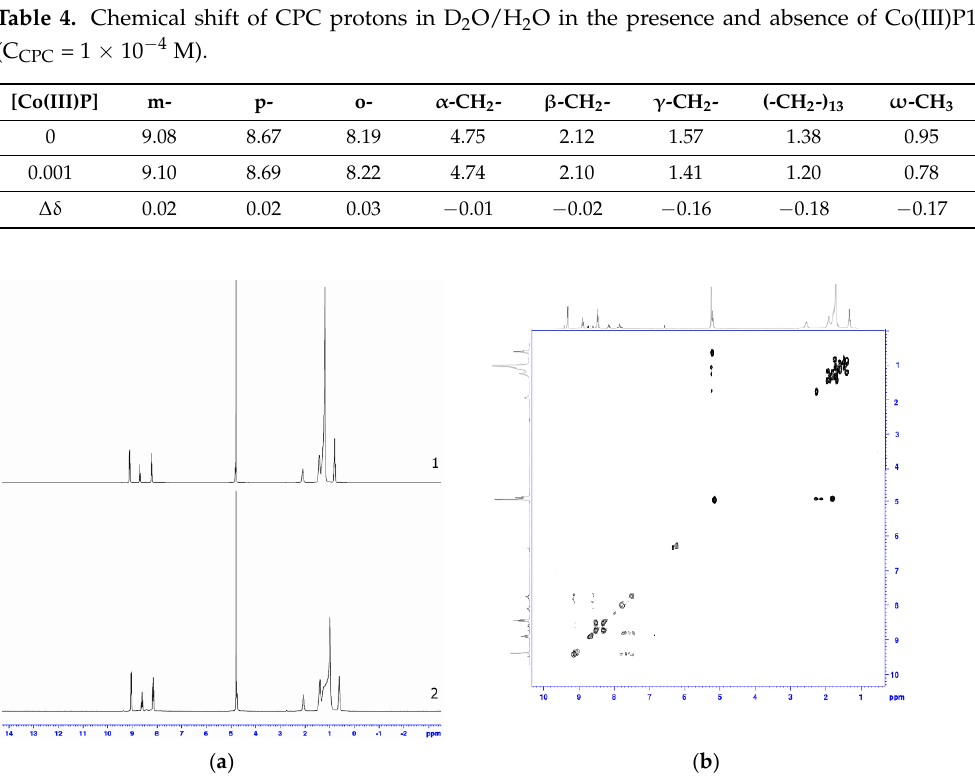
Figure 9. ( a ) 1 Н-NMR-spectrum of the CPC in the absence (1) and in the presence of Со(III)P1 (2) (D 2 O/H 2 O) in the region of 0.5–2.5 ррm and ( b ) 1 H– 1 H two-dimensional correlation